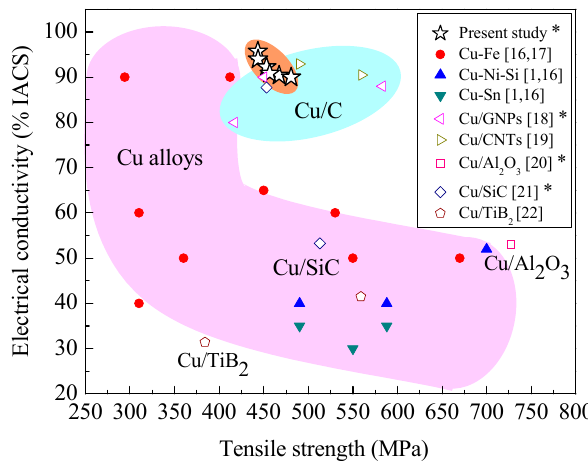
Figure 5. Electrical conductivity versus tensile strength of ARBed Cu ( N = 5, 10, 12, 20, 27, 30) in this study, high-strength, high-conductivity Cu alloys [1,16,17] and common Cu based composites [18–22]. * tensile strength is calculated as H /3